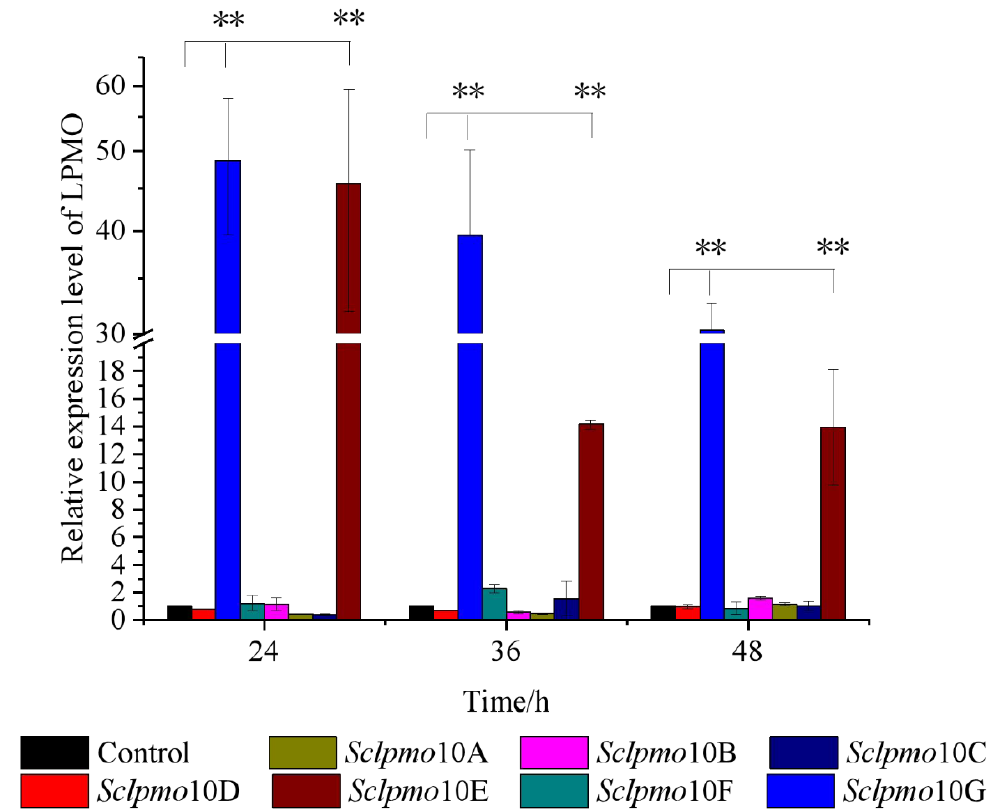
Figure 1. Time course of relative transcript level of Sclpmo s in the presence of 0.1% chitin. Relative expression level of Sclpmo s cultured with glucose as control. All experiments were performed in triplicate and standard deviation analysis was conducted (SD, n = 3). Asterisks indicate significant differences ( p < 0.01).